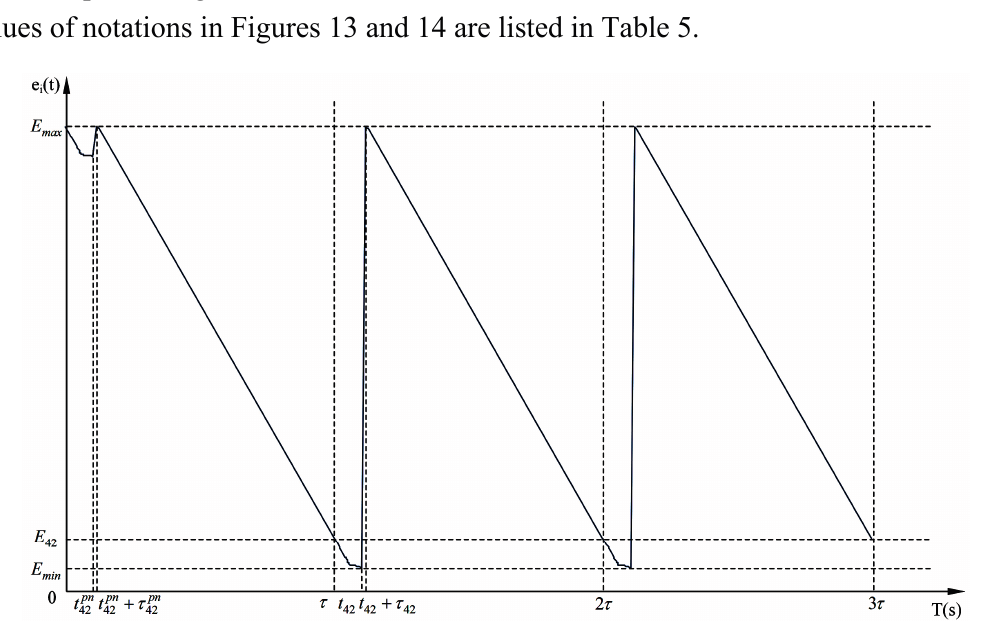
Figure 13. The energy-time curve of the 42nd sensor node without extra energy replenishing in the pre-normal replenishing stage and the 1st and 2nd normal replenishing cycles.